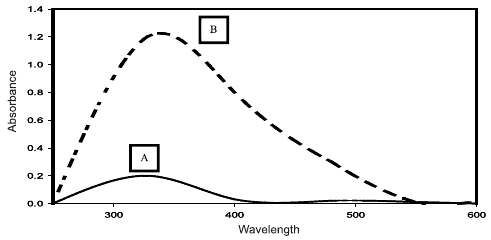
Fig. 5. UV–visible spectra (250–600 nm) of pyocyanin extracted from the secondary metabolites of a 4-day-old culture of P. aeruginosa DM1 grown with 200 mg L ”1 of zinc nitrate (A) and without zinc nitrate (B),